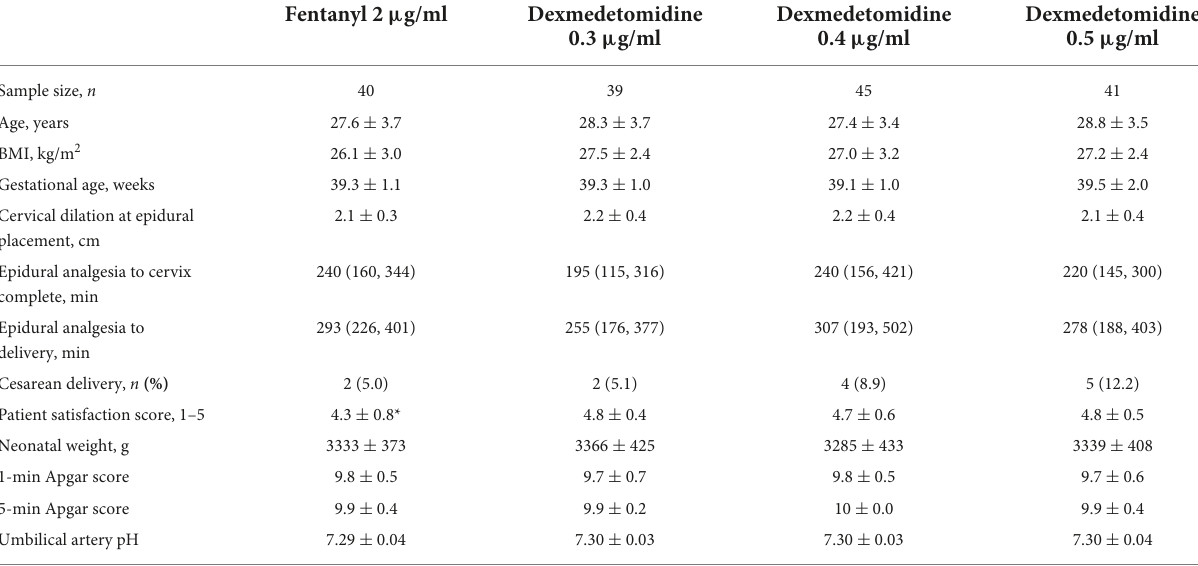
TABLE 1 Demographics, labor characteristics, and neonatal outcomes of laboring patients.